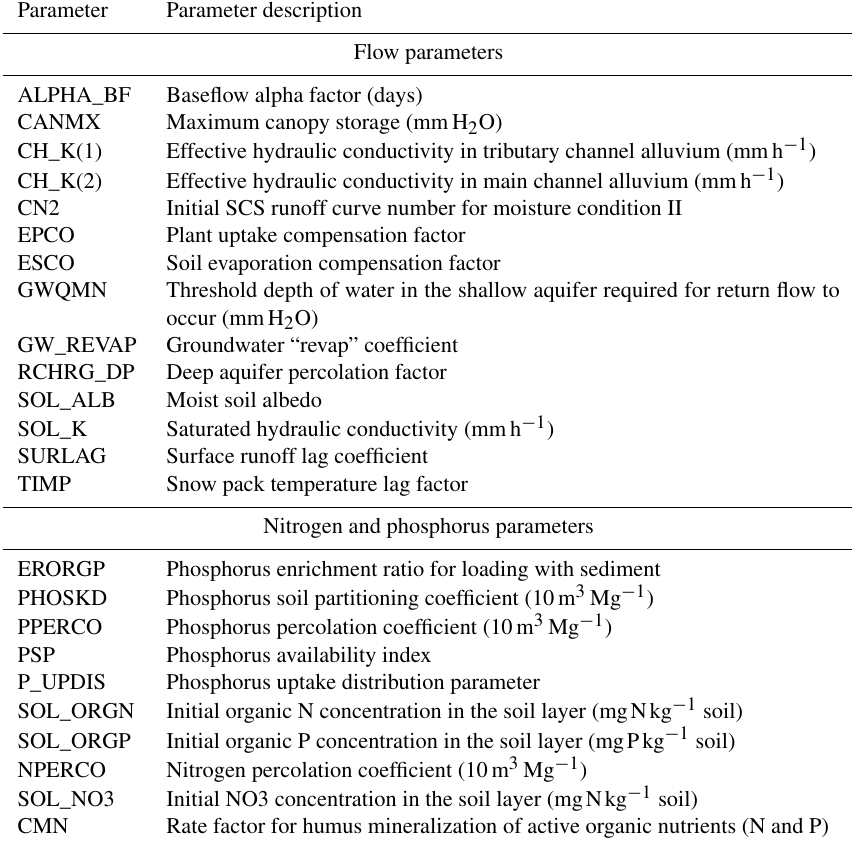
Table 4. The most sensitive parameters obtained from the sensitivity analysis in SWAT model for the analysed catchments (source: G˛ebala, 2015; Wilk,